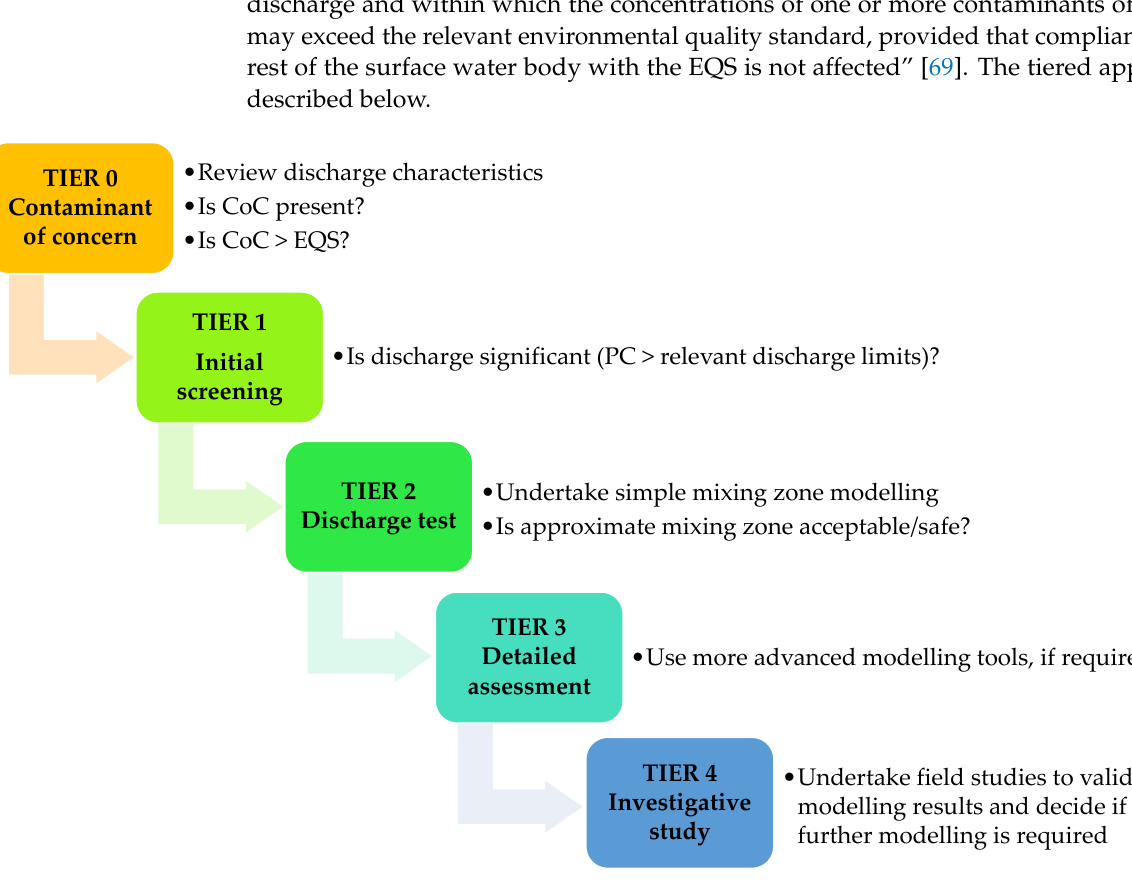
Figure 3. Tiered approach for determining the size and acceptability of discharge mixing zones recommended by the European Commission. Based on information reported by the European Commission [69]. ‘CoC’—contaminants of concern, ‘EQS’—environmental quality standards, and ‘PC’—process contribution or the contribution of the discharge to the EQS after full mixing. Tier 0 is a high-level assessment to identify the presence of discharges with the poten- tial to cause EQS exceedance for CoC [69]. Any discharges that do not contain contaminant concentrations above the EQS do not require the determination of a mixing zone because the EQS would provide a sufficient level of environmental protection. In Tier 1,